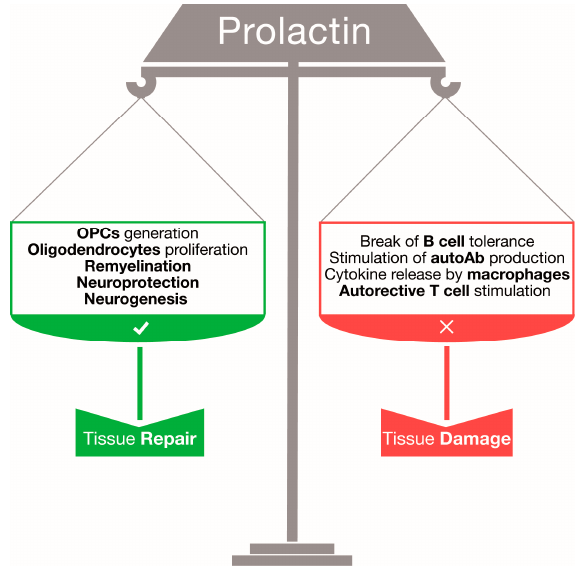
Figure 1. The potential duality of prolactin (PRL) in central nervous system (CNS) autoimmunity. PRL might promote CNS repair by influencing oligodendrocyte progenitor cells (OPC) generation and oligodendrocyte proliferation [29], and favoring remyelination [29], neuroprotection [25–28] and neurogenesis [21–24]. However, PRL might also promote CNS damage by breaking B cell tolerance [42–46], sustaining autoantibody (autoAb) production [45] and macrophage release of cytokines [30–32] and stimulating autoreactive T cells [37,40].